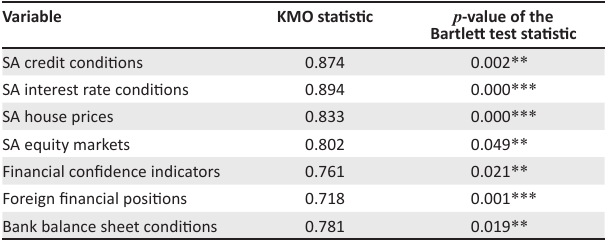
TABLE 1: Kaiser-Meyer-Olkin (KMO) statistic and p -value of Bartlett’s test statistic. Variable KMO statistic